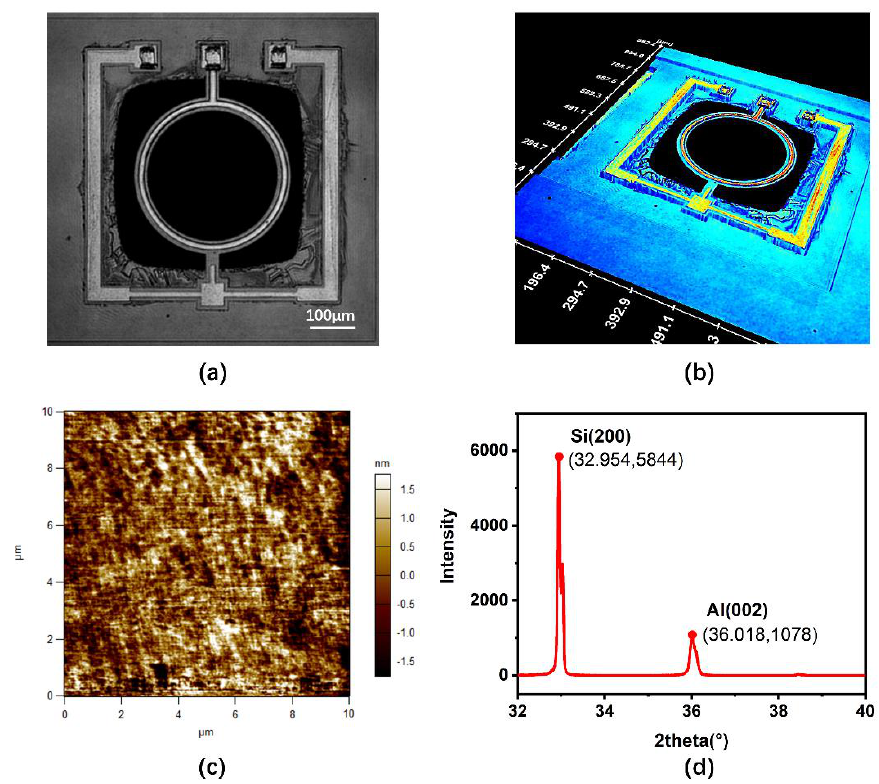
Figure 5. ( a ) 2D optical holographic image of the resonator, ( b ) 3D optical holographic image of the resonator, ( c ) Atomic force microscopy (AFM) image of AlN thin film, ( d ) X-ray diffraction patterns of AlN film.